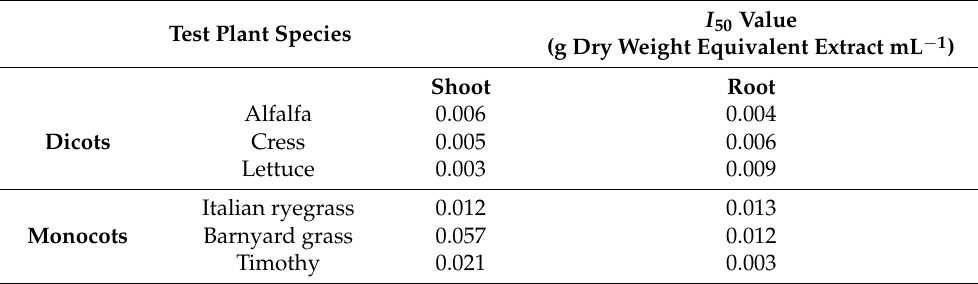
Table 1. Required concentrations of A. reticulata leaf extracts for 50% shoot and root growth inhibition ( I 50 values) of the six test